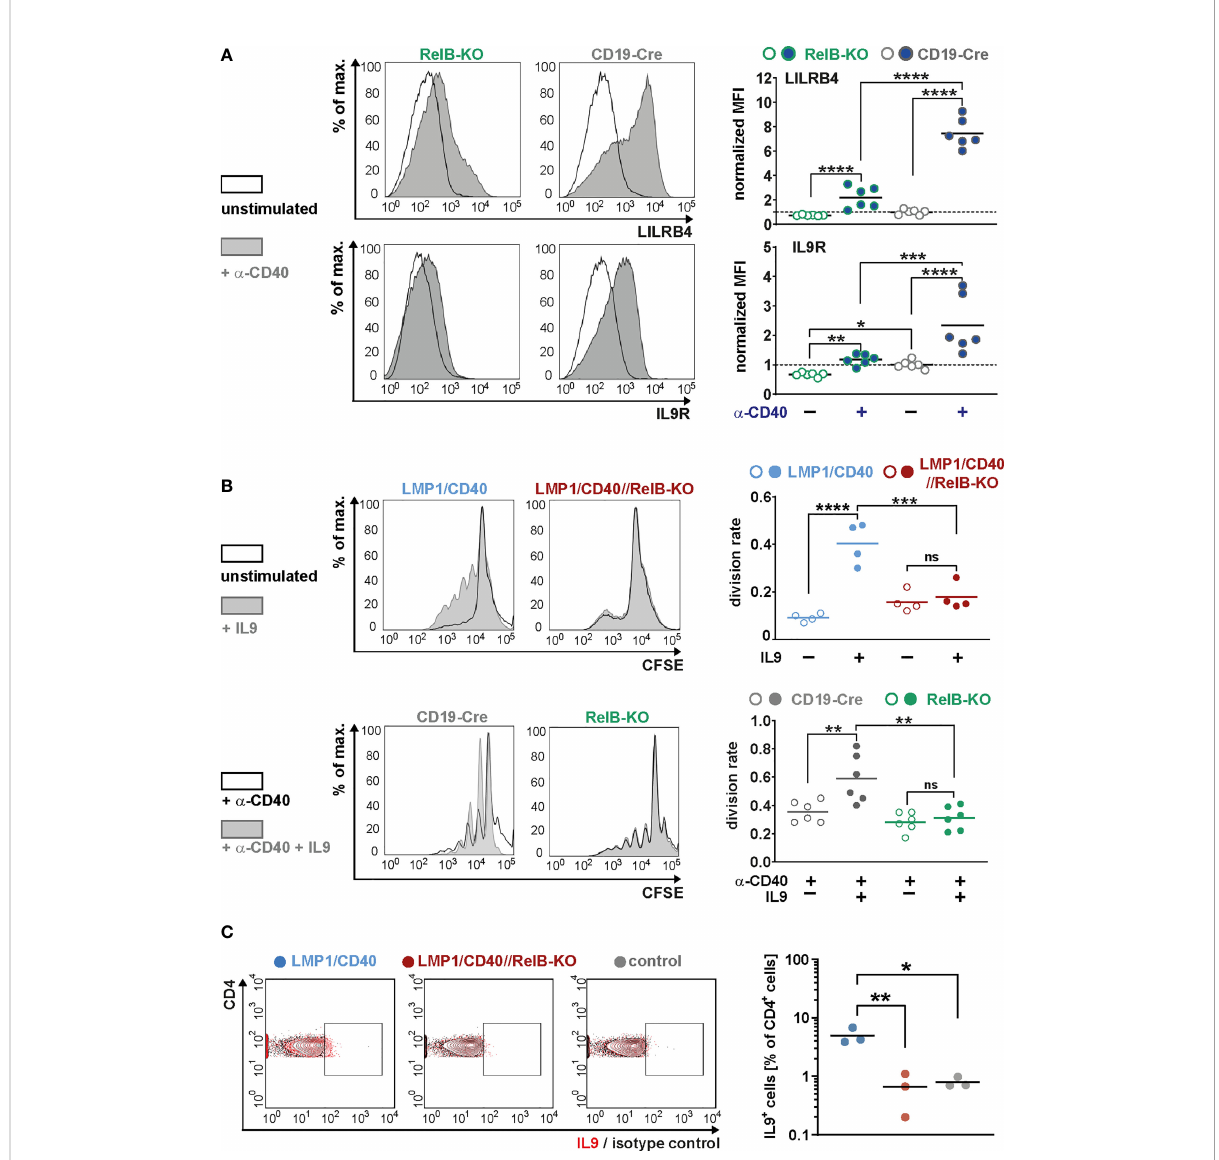
FIGURE 7 RelB-dependent upregulation of LILRB4 and IL-9R upon CD40-stimulation: (A) MACS puri fi ed B cells were cultured in the presence of an agonistic anti-CD40 antibody or were left unstimulated for two days. The surface expression of LILRB4 and IL-9R was determined by FACS. Representative histogram overlays of unstimulated and CD40-stimulated B cells from RelB-KO and CD19-Cre control mice are shown. The histograms are pre-gated on live cells. The graphs compile the values of N =6 independent experiments. For normalization, the individual values were divided by the average of the unstimulated controls. Due to their log-normal distributions, values were logarithmically transformed before statistical analysis with an ordinary two-way ANOVA, Tukey´s multiple comparisons test. (B) The proliferation of splenic B cells isolated from mice with the indicated genotypes was analyzed after CSFE staining. In the upper row, splenic B cells were cultured with and without IL9 stimulation for three days. In the lower row, cells were additionally stimulated with CD40. Representative histogram overlays of the CFSE staining of stimulated and unstimulated B cells from the indicated genotypes are shown. The histograms are pre-gated on live cells. The graphs compile the division rates in the individual samples from N =4 (LMP1/CD40; LMP1/CD40//RelB-KO) and N =6 (RelB-KO; CD19-Cre) mice. Statistics were calculated by an ordinary two-way ANOVA, Tukey´s multiple comparisons test. (C) Representative FACS plot for the detection of IL-9 producing T cells. The FACS plot shows an overlay of CD4 + T cells stained with an anti-IL-9 antibody (red) or the corresponding isotype control (black) in the indicated genotypes (control: CD19-Cre). The gates for IL-9 positive cells was set according to the isotype control. The graph compiles the percentages of IL-9 + CD4 + T cells from N =3 independent experiments. Ordinary one-way ANOVA with Tukey ’ s multiple comparison was performed. (A – C) p-values are indicated as * P<0.05, ** P<0.01, *** P<0.001, **** P<0.0001. Dots represent values from individual mice, and the lines indicate means. n.s. = not signi fi